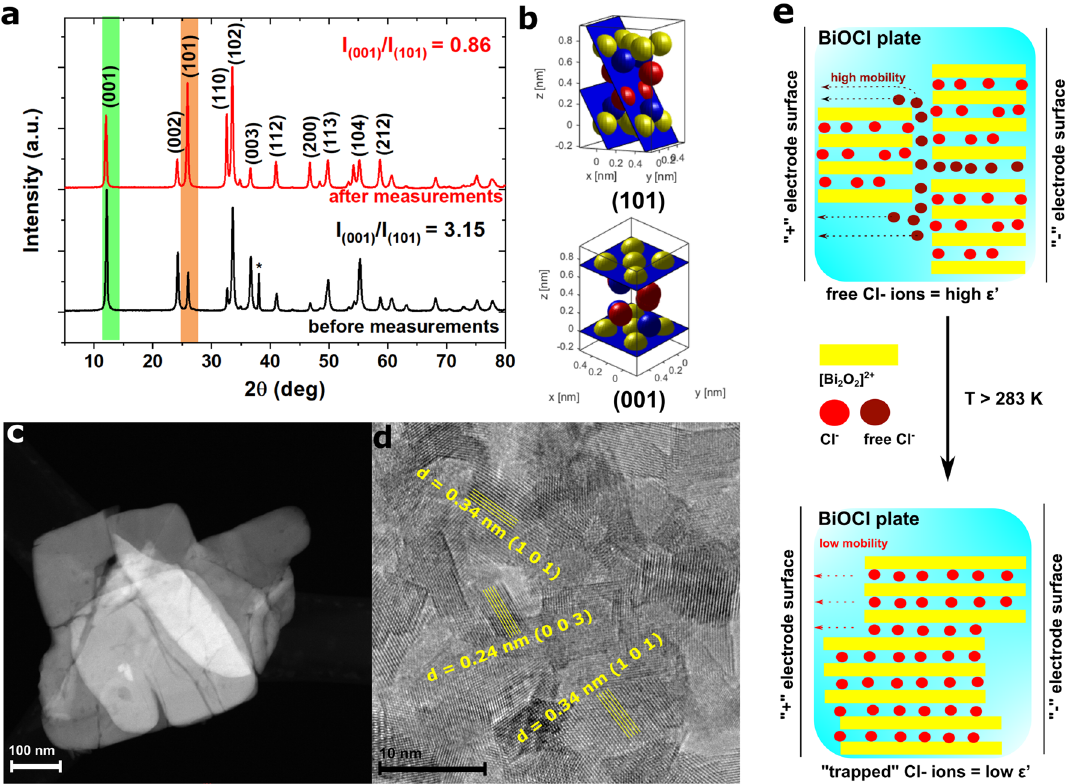
Figure 3. ( a ) Comparison of XRD patterns of the same BiOCl sample before and after measurements, confirming structure rebuilding [the (*) peak represents the X-ray specimen holder]; ( b ) visualization of two characteristic planes in the BiOCl unit cell marked on (a): yellow balls represent Bi 3+ ions, blue ones O 2− , and red ones Cl − ions (CrysTBox cellViewer 1.13 31,32 ); ( c ) HAADF STEM image of BiOCl plates after compression and heat treatment; ( d ) TEM image of BiOCl plate after compression and heat treatment with marked planes characteristic of BiOCl; ( e ) schematic representation of structure rebuilding and influence of this process on chloride ion